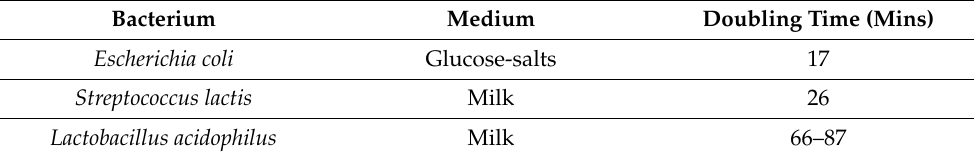
Table 1. Doubling time of a sample of three species of living bacteria [42].